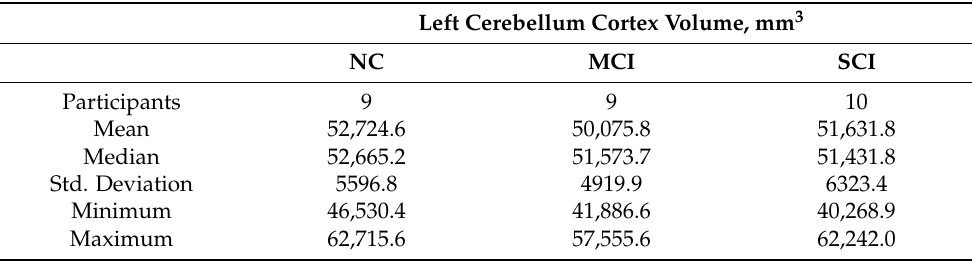
Table 3. Descriptive statistics for left cerebellum cortex volume in participant groups with normal cognition (NC), mild cognitive impairment (MCI), and moderate/severe cognitive impairment (SCI).